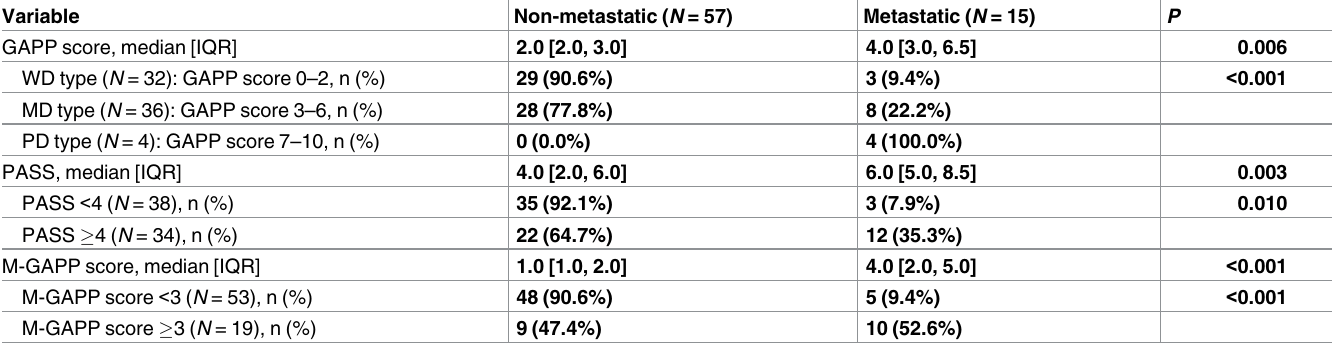
Table 6. Comparison of the GAPP score, PASS, and M-GAPP score for predicting metastatic potential in PPGL. Variable